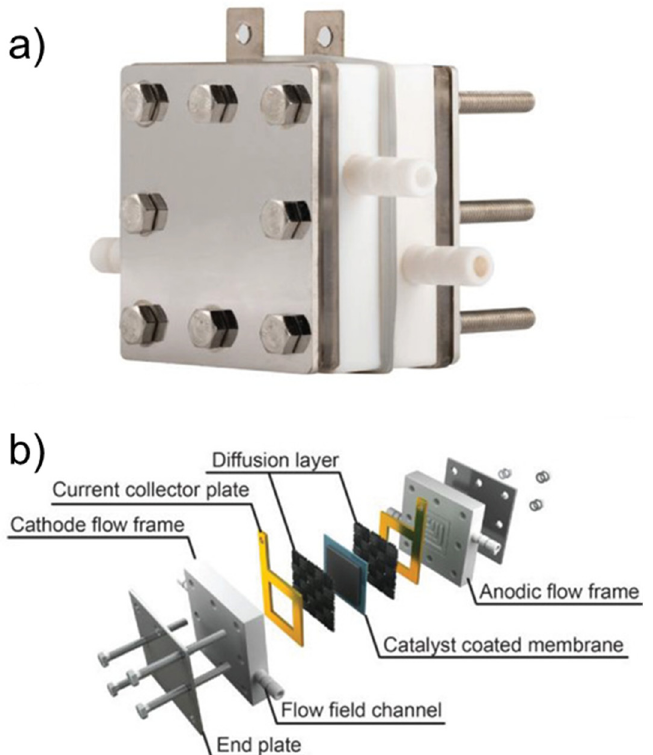
Figure 14. Flow ECH cell ( a ) assembled ( b ) expanded view of the structural components. Reproduced with permission from ref [43]. Copyright 2019 Wiley-VCH.